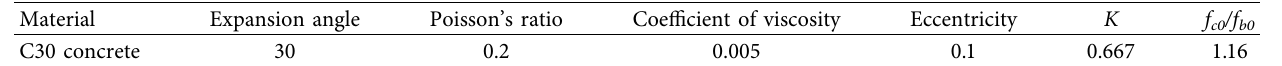
Table 3: Concrete plastic damage parameter.